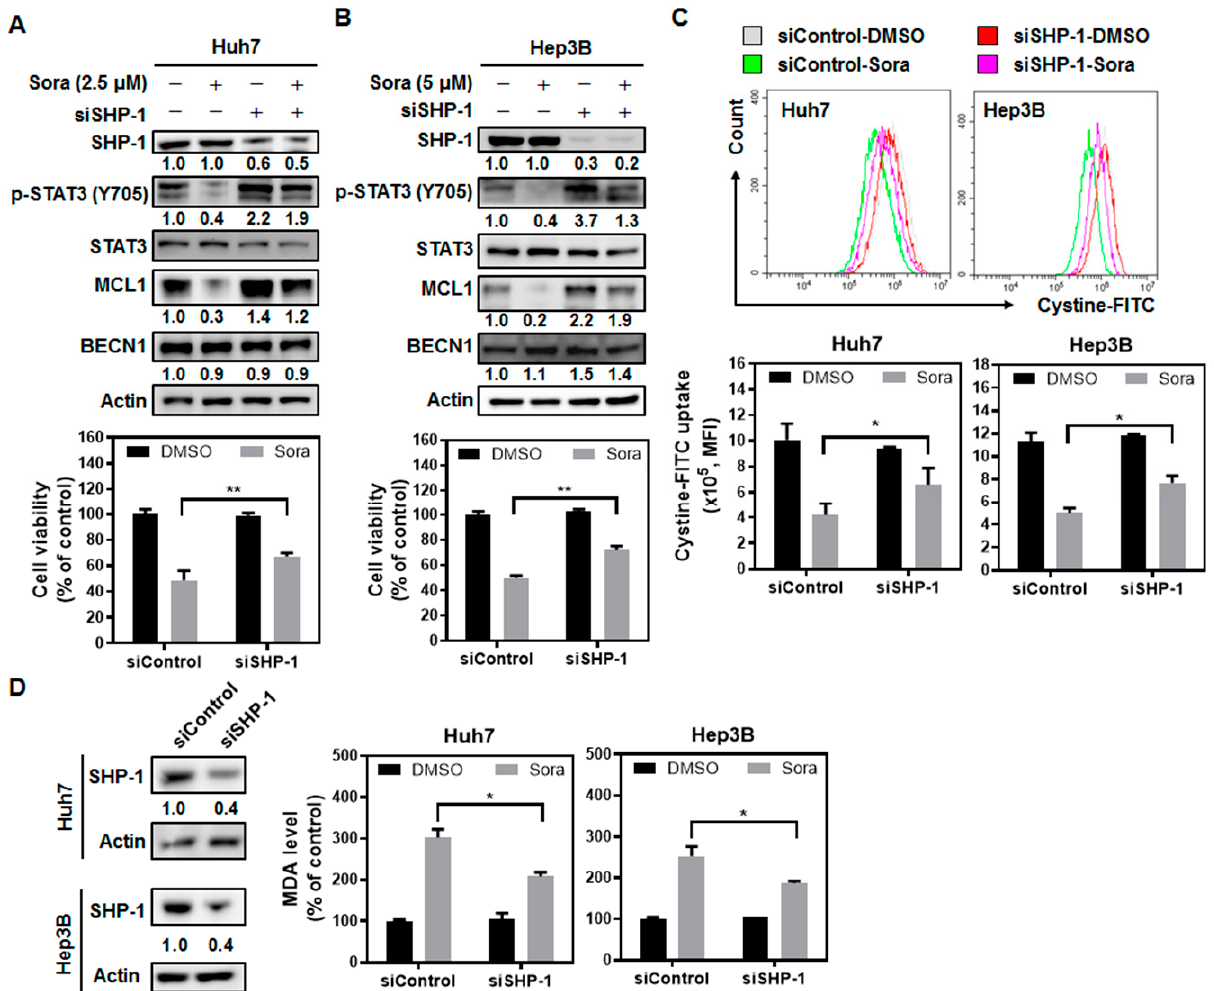
Figure 3. Src homology region 2 domain-containing phosphatase-1 (SHP-1) silencing rescues HCC cells from sorafenib-induced ferroptosis: ( A ) Huh7 and ( B ) Hep3B cells were transiently transfected with specific siRNA targeting SHP-1 (siSHP-1) overnight. Then, the cells were treated with 2.5 µM (Huh7 cells) or 5 µM (Hep3B cells) sorafenib for another 16 h. The expression of downstream molecules of SHP-1 was examined by immunoblotting ( upper panel ), and the cell viability was determined by MTT assay ( lower panel ). ( C ) After sorafenib treatment, the changes in cystine–FITC uptake and the extent of lipid peroxidation ( D ) were assessed via appropriate biochemical analyses. Scrambled control siRNA (siControl). Columns: mean; bars: SD (n ≥ 3). Statistical significance was assessed by employing the Mann–Whitney U test (*, p < 0.05; **, p < 0.01).